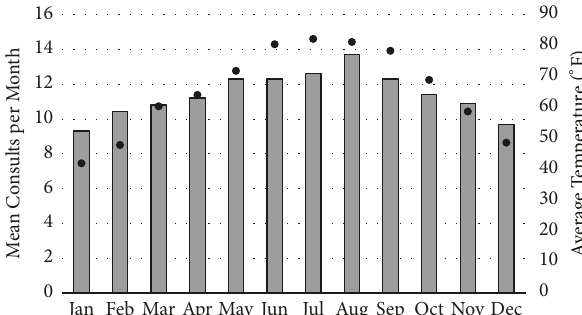
Figure 1: Average number of consults per month and average daily temperature per month (scatter plot). The average daily number of consults increases with increasing average monthly